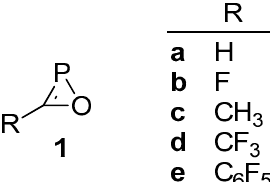
Figure 1. 1 H -Oxaphosphirene derivatives studied.